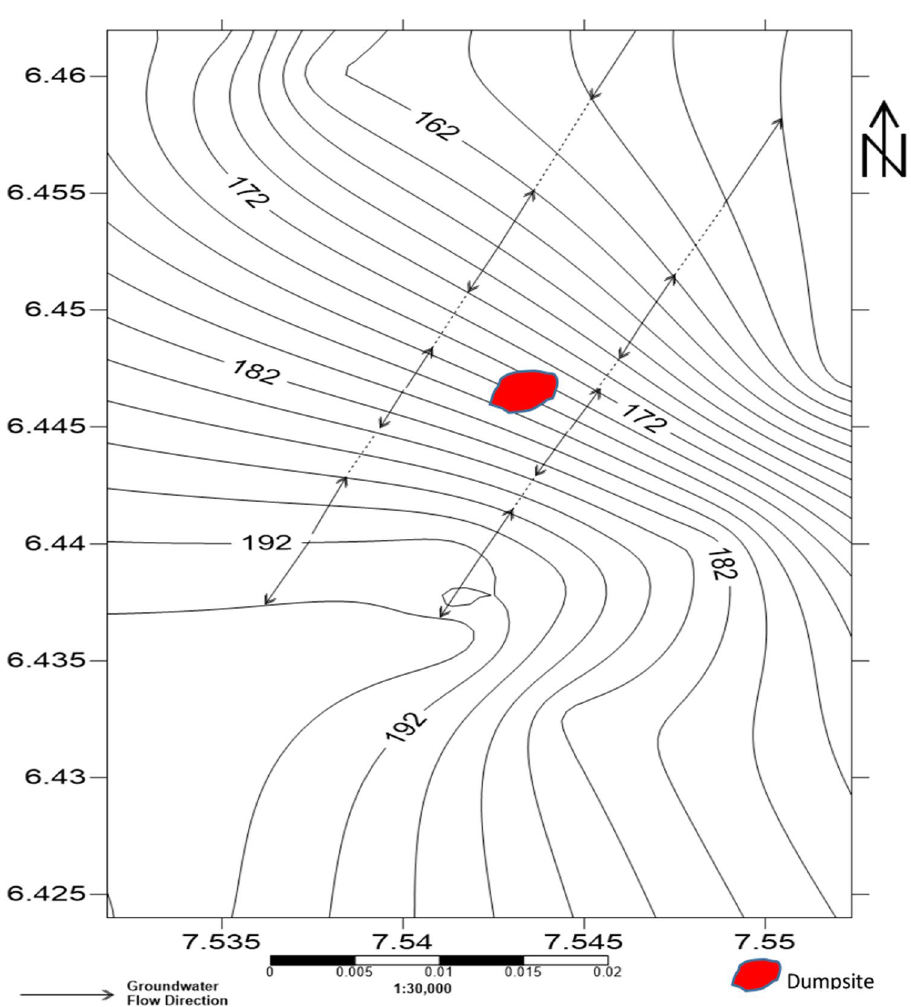
Fig. 6 Groundwater flow direc- tion based on hydraulic head distribution of the